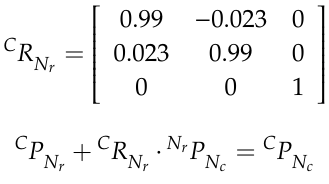
Table 3. Estimated displacement vectors (mm).